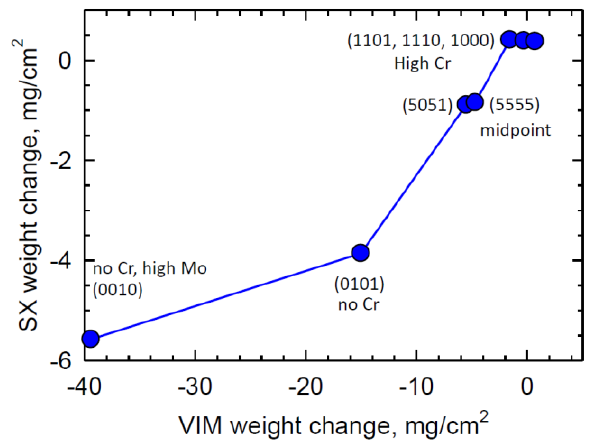
Figure 14. Correlation of improved single crystal oxidation for corresponding VIM results for the same 1100 °C, 200 h cyclic